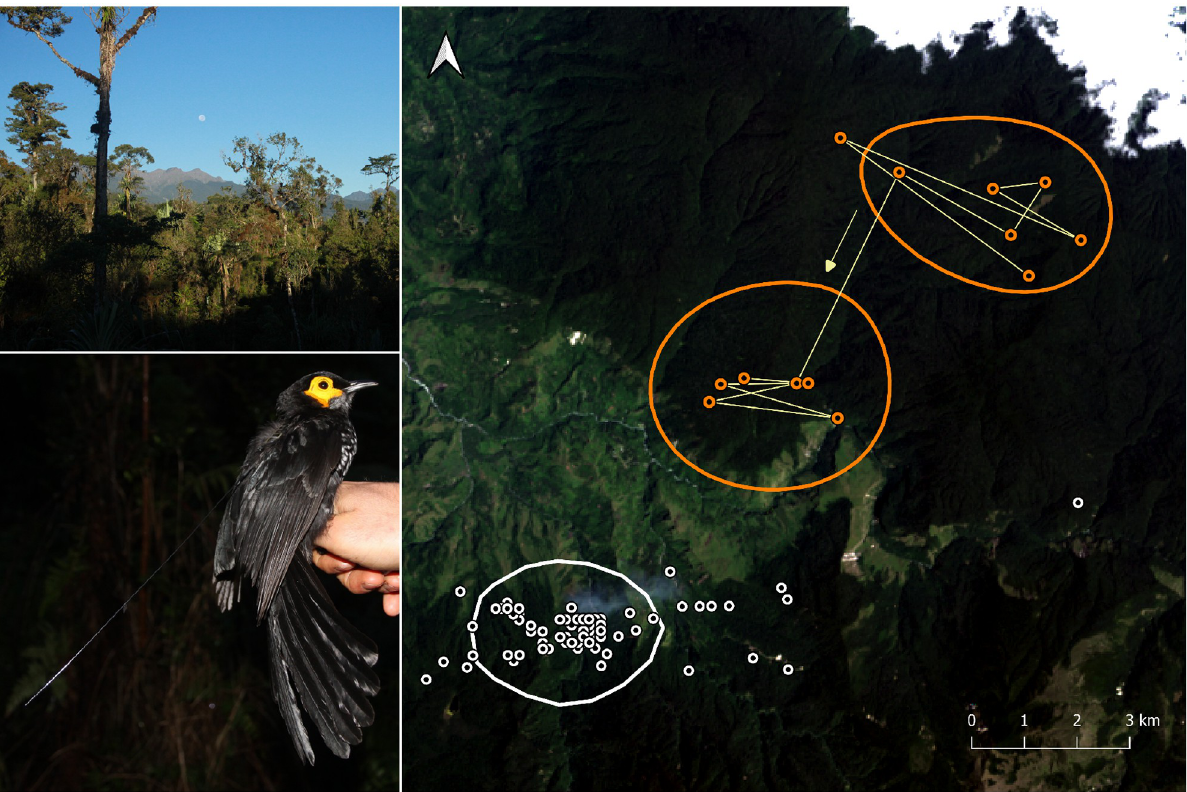
Fig 2. A home range shift by a Spangled Honeyeater revealed by satellite tracking data. Points from a stationary control transmitter (white) provide context for interpreting movement patterns of the honeyeater (orange). Side panels show montane forest habitat in New Guinea and a Spangled Honeyeater fitted with a transmitter. Photos: Knud Andreas J ø nsson. Landsat-8 image courtesy of the U.S. Geological Survey.